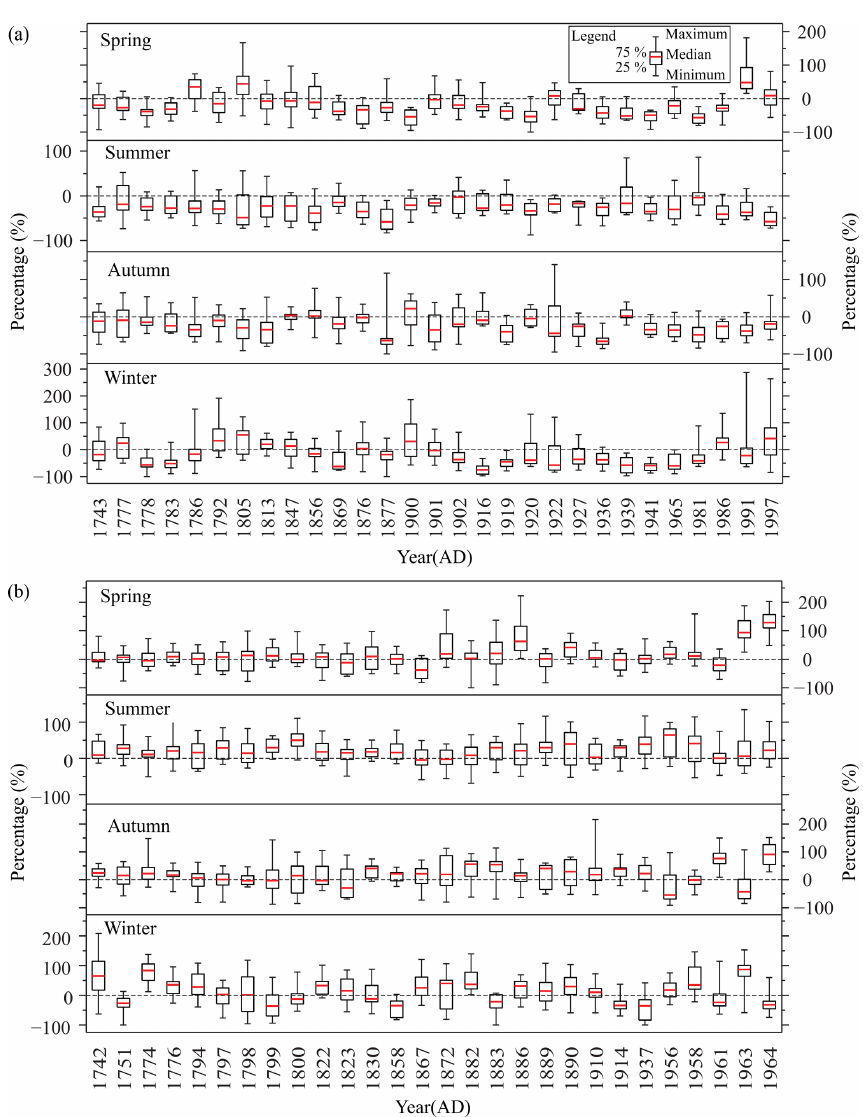
Figure 3. The box-whisker plot of seasonal precipitation anomaly percentage among sites for each extreme drought (a) and flood (b)